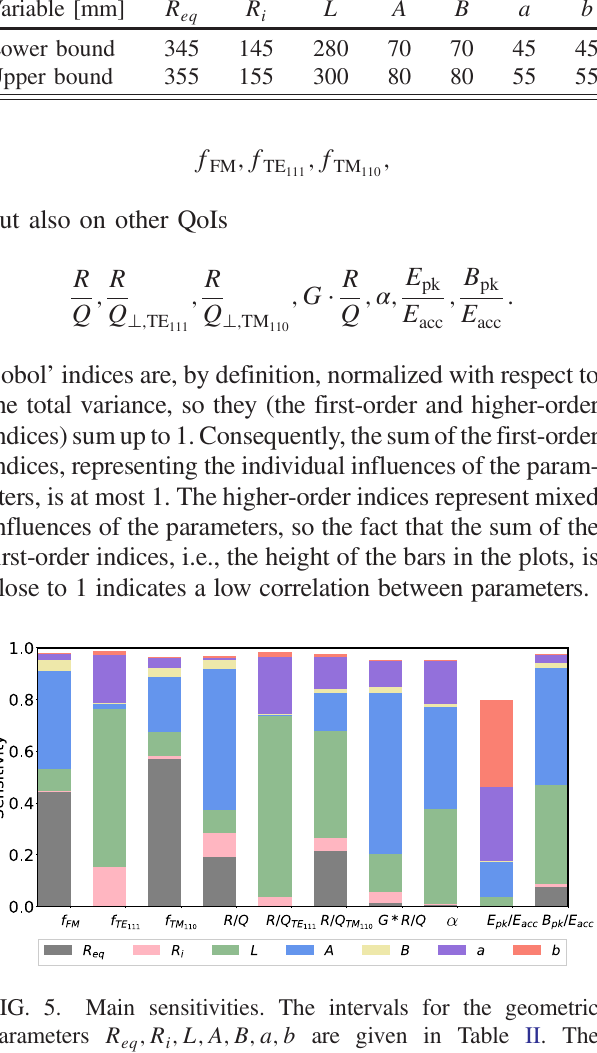
TABLE I. Eq. (4) for a few relevant values of N and p .